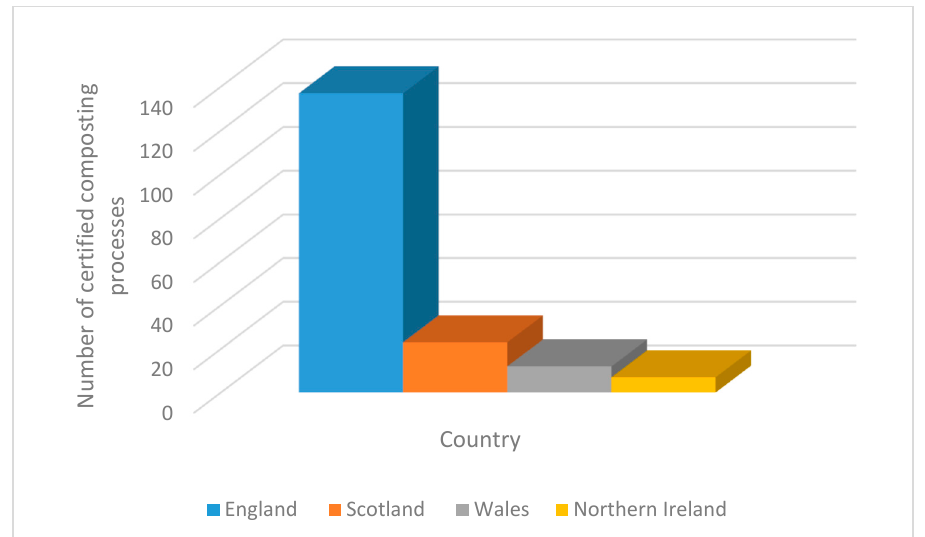
Figure 2. The distribution of certified compost makers throughout the UK; data extracted from Hasznos (2019) shows that the highest number of compost makers are in England as 137 units, Scotland, 23, Wales, 12, and Northern Ireland, 7 [127] .